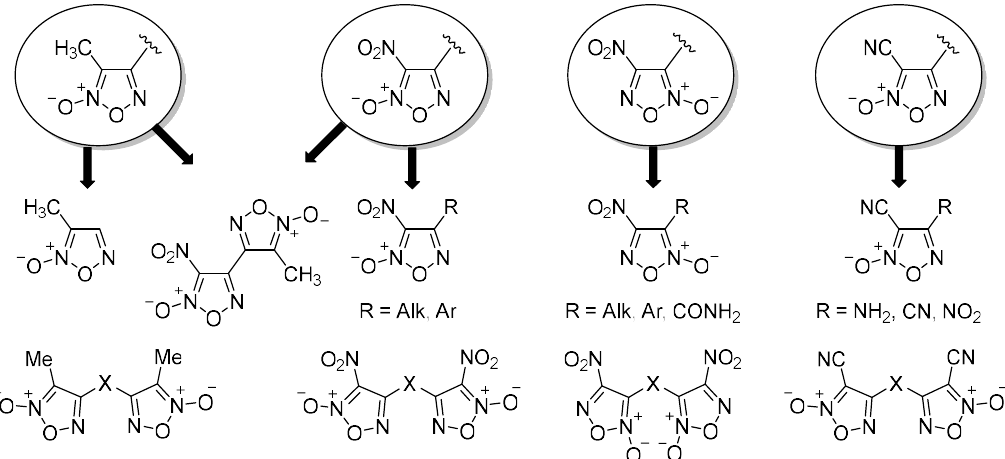
Figure 2. Schematic illustration of the methyl-, nitro-, and cyano-derivatives of furoxan studied in the present